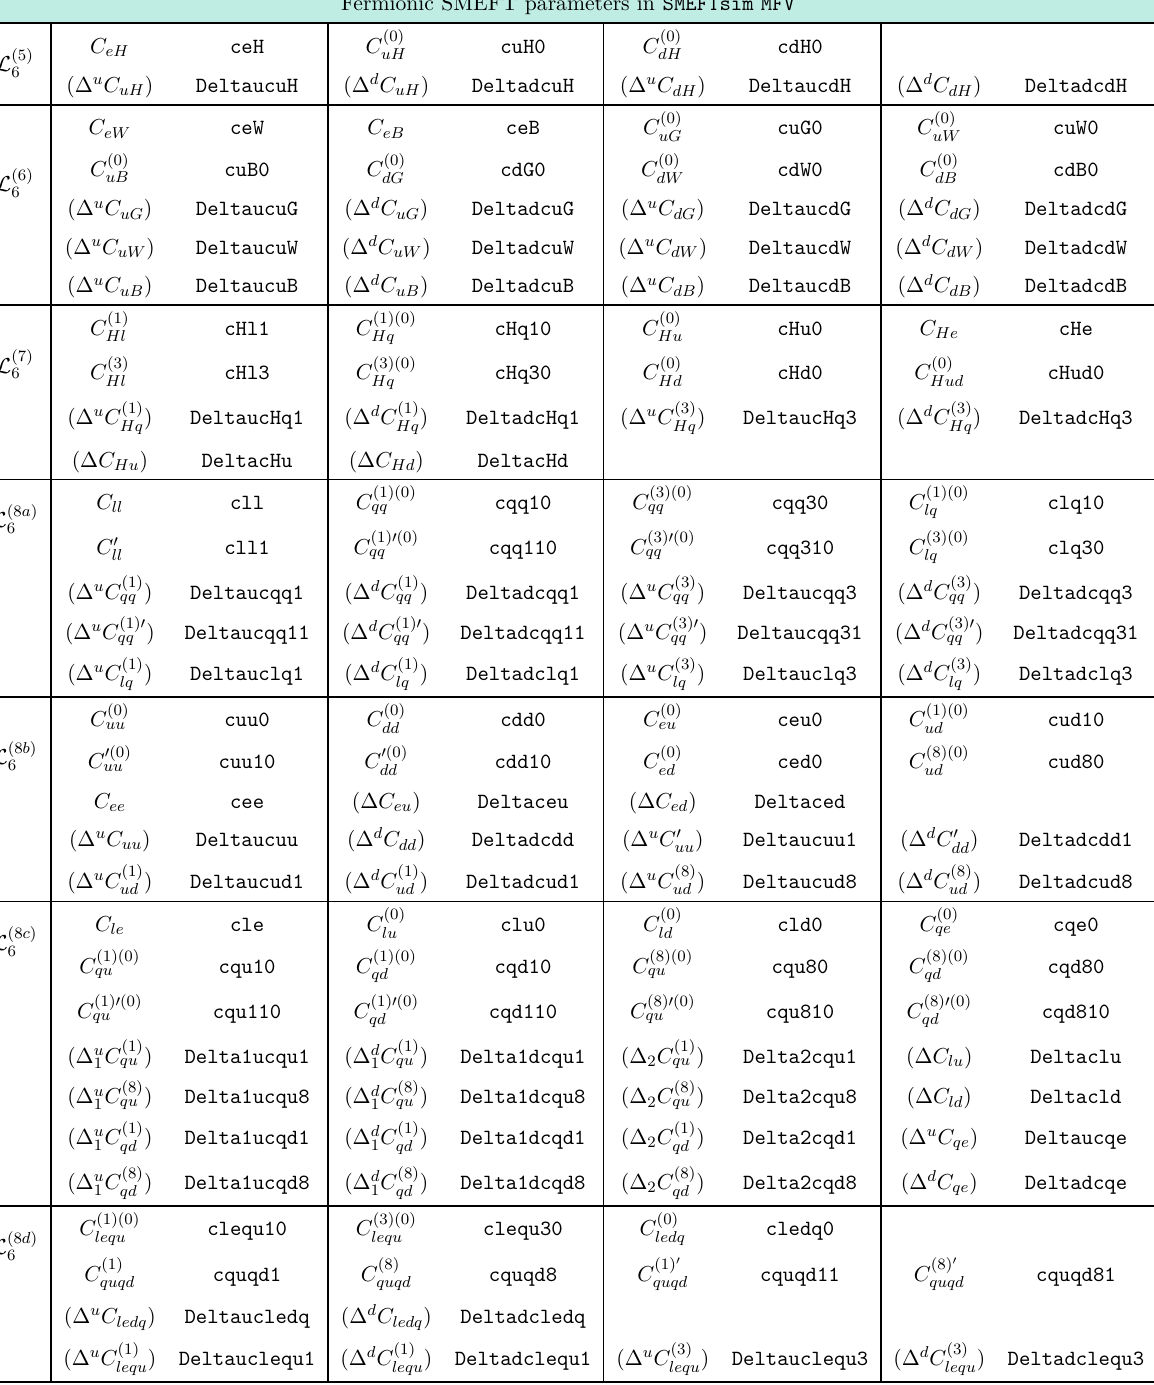
defined in the MFV model, see section 6